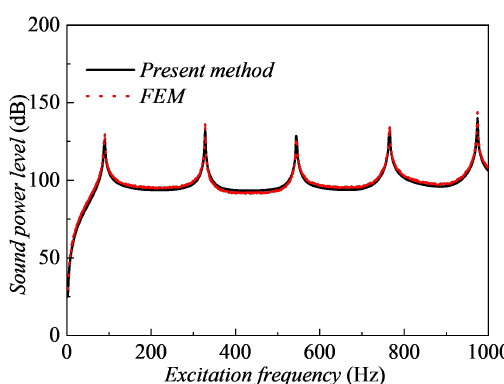
Figure 13: Sound pressure level with different elastic boundary conditions